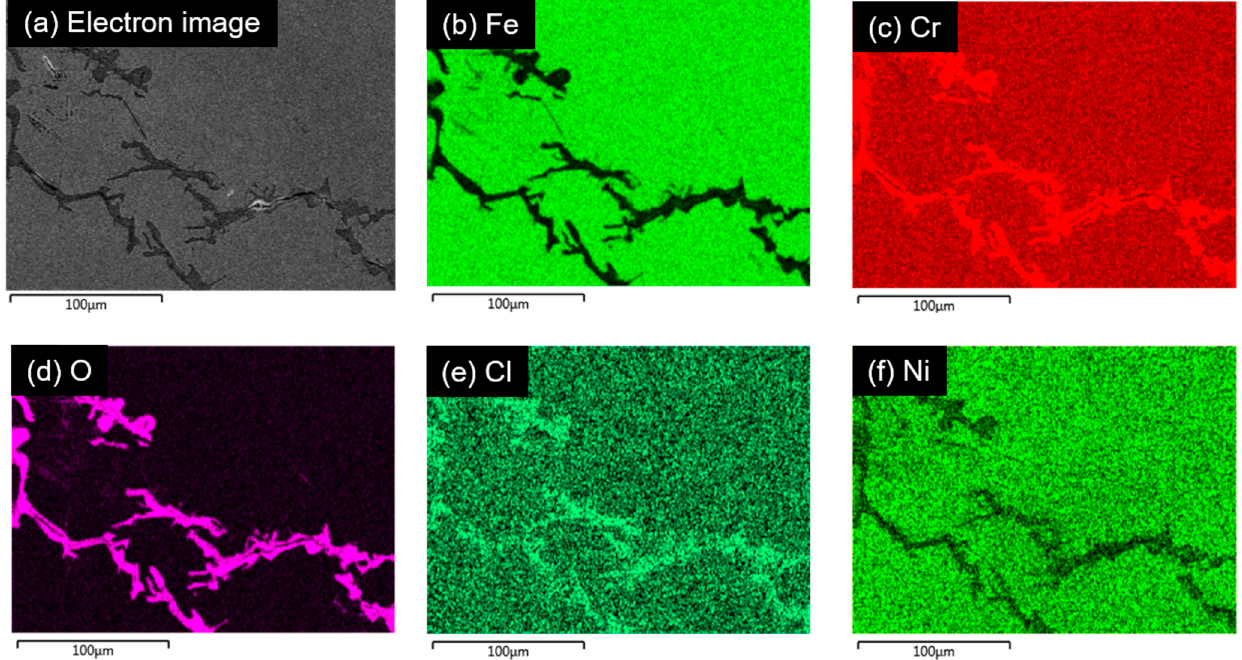
Figure 5. Elemental distribution maps obtained from the cracked area. From top left to bottom right, secondary electron image ( a ), elemental distribution maps of ( b ) Fe, ( c ) Cr, ( d ) O, ( e ) Cl, and ( f ) Ni. The gap generated by the crack is filled with Cr-rich oxide and the Cl element is also enriched at the oxide region.